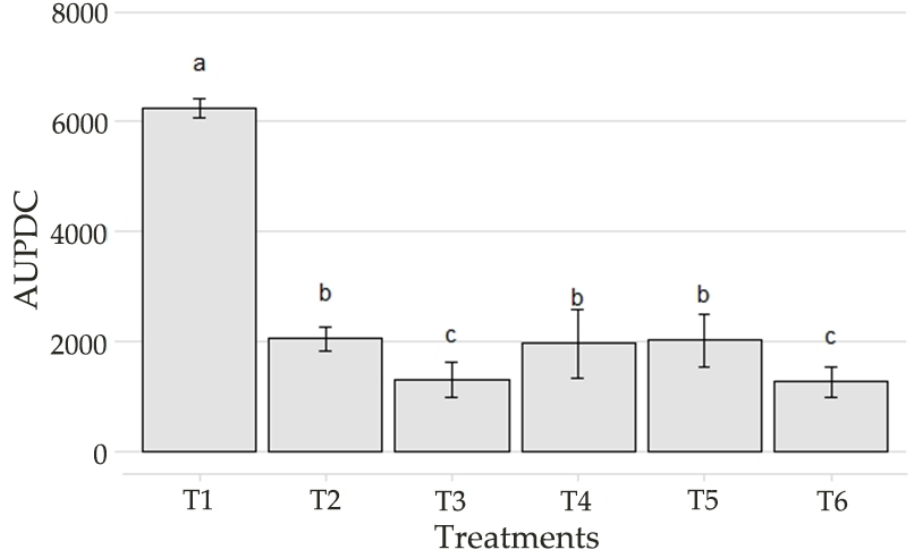
Figure 6. AUPDC of IFM data for each treatment (T1: water; T2: chemical control; T3: biological control; T4: B.BV10 1 g/L; T5: B.BV10 2 g/L; and T6: B.BV10 4 g/L). Means ± SE followed by the same letter did not differ significantly from each other by the Scott – Knott test ( p < 0.05).